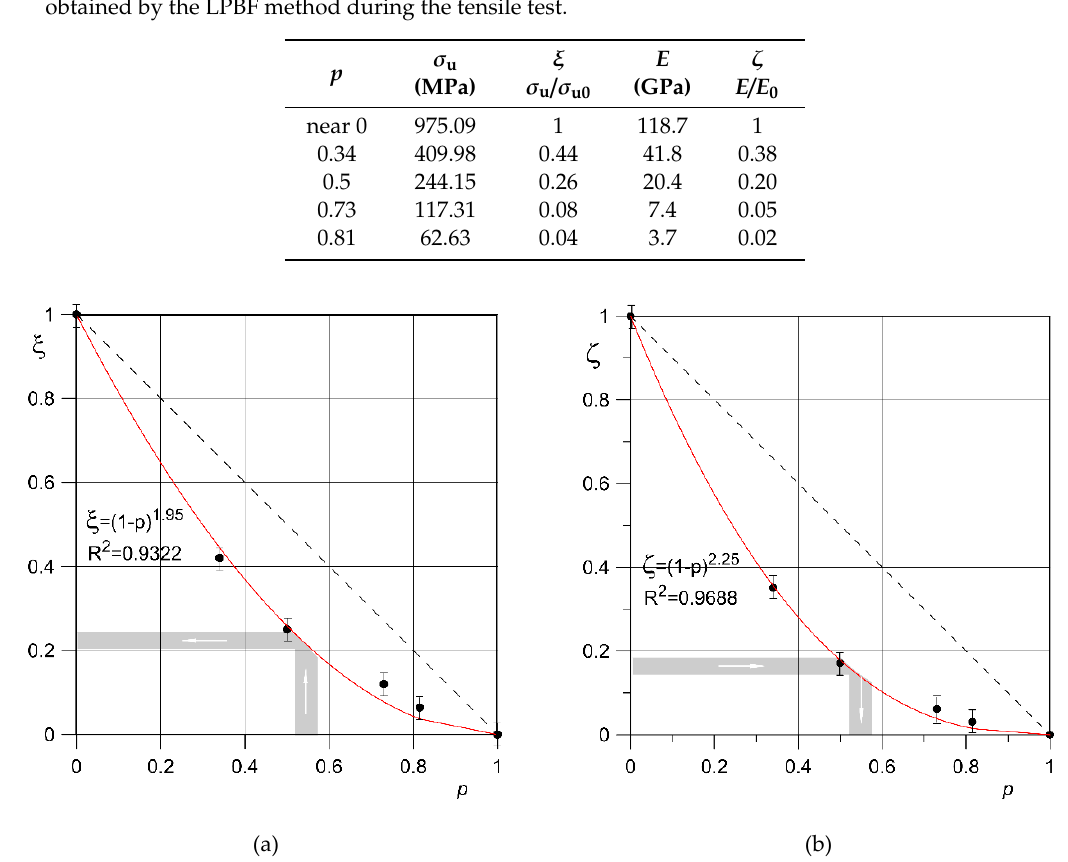
Figure 8. Values of ξ ( a ) and ζ ( b ) coefficients for samples of Ti6Al4V titanium alloy with diamond structure and different porosity.